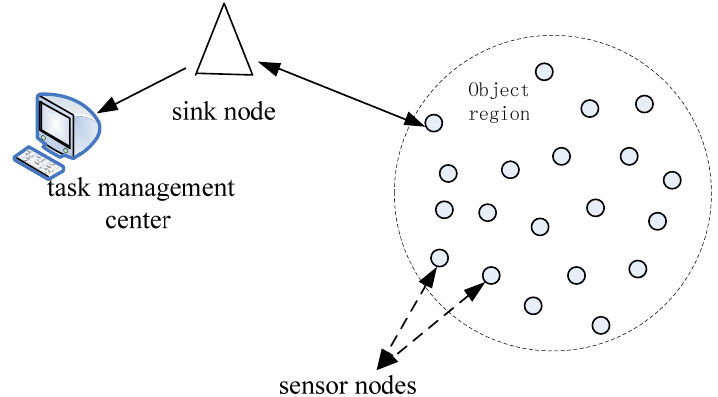
Figure 1. Typical architecture of a wireless sensor